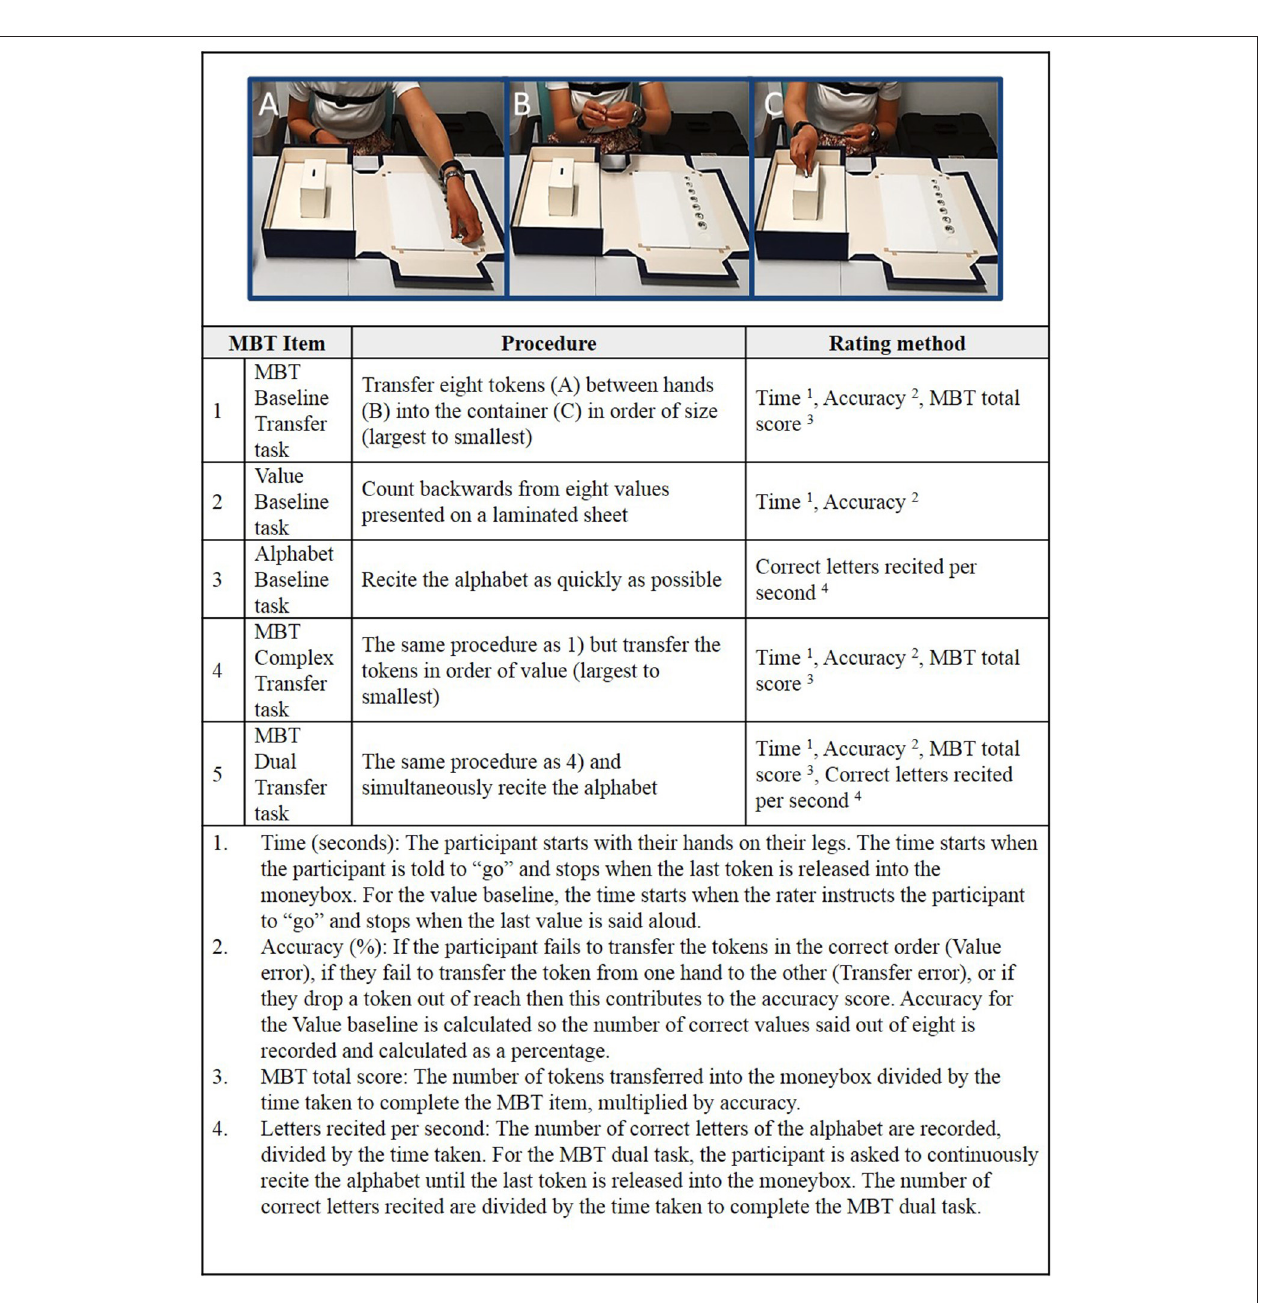
FIGURE 2 | The Moneybox test (MBT) procedure and rating method. The subject is required to pick up the tokens with their non-dominant hand (A) , transfer to their dominant hand (B) , and release it into a moneybox (C) . The time (in seconds) taken to perform the transfer tasks, the accuracy (referring to any errors or dropped tokens made during the task) are recorded and used to calculate the MBT total score. The alphabet rate is the number of correct letters of the alphabet recited per second and used to compare alphabet baseline performance to alphabet performance during the Dual Transfer task.